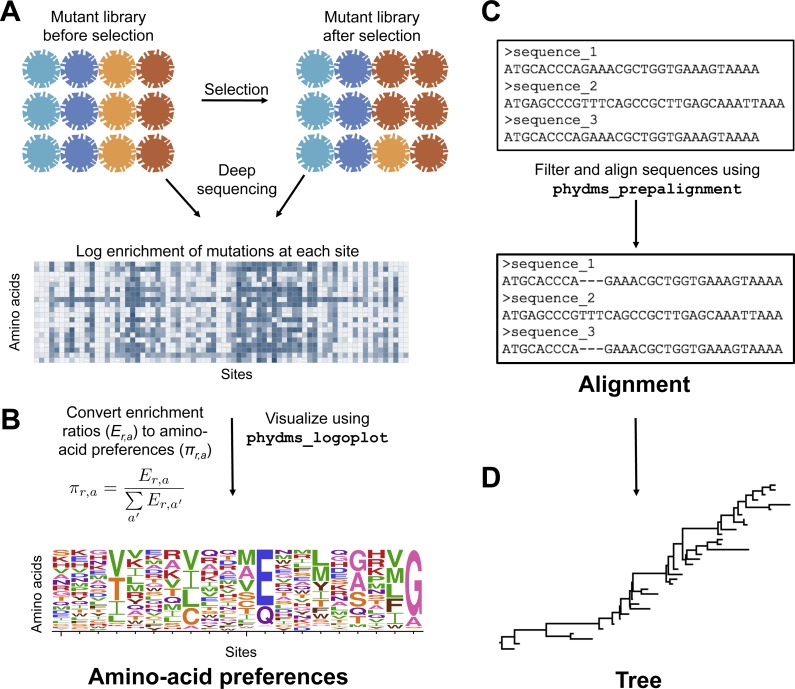
Workflow for preparing input data to phydms.Analysis with phydms requires amino-acid preferences measured by deep mutational scanning, a codon-level alignment of naturally occurring sequences, and a phylogenetic tree topology. (A) Deep mutational scanning involves performing a functional selection on a library of mutant genes, and using deep sequencing to quantify the enrichment or depletion of each mutation (relative to wildtype) after selection. (B) The amino-acid preferences used by the ExpCM can be calculated by normalizing the enrichment ratios for mutations to sum to one at each site. (C) We created a filtered, codon-level alignment of naturally occurring sequences using phydms_prepalignment. (D) We used phydms_comprehensive to automatically generate a tree topology from the filtered alignment using RAxML.